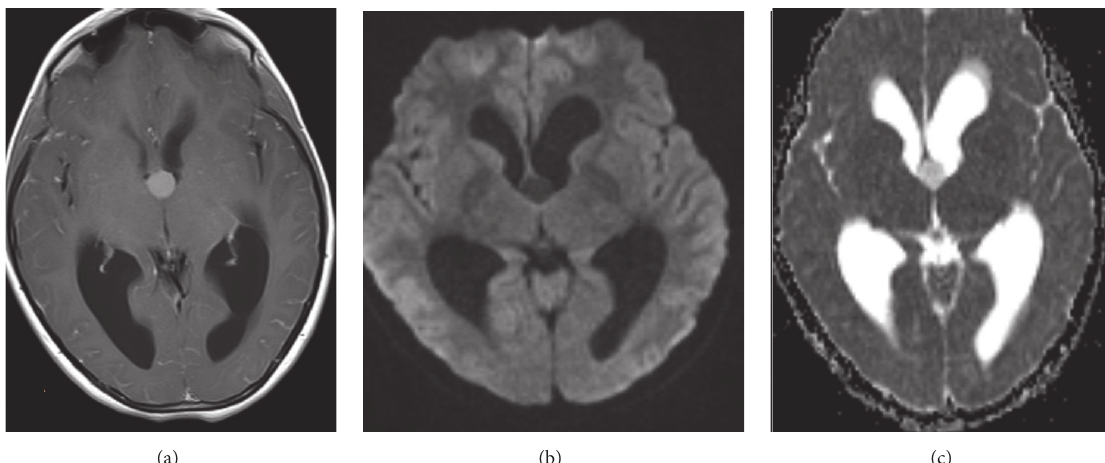
Figure 3: (a) TIWI + C: subtle enhancement after intravenous gadolinium injection. (b & c) No elevated diffusion pattern.